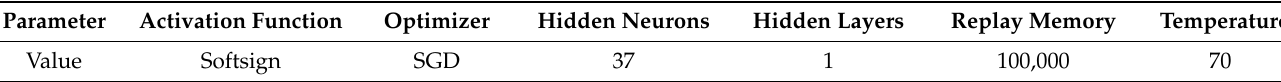
Table 1. Parameters of the implemented